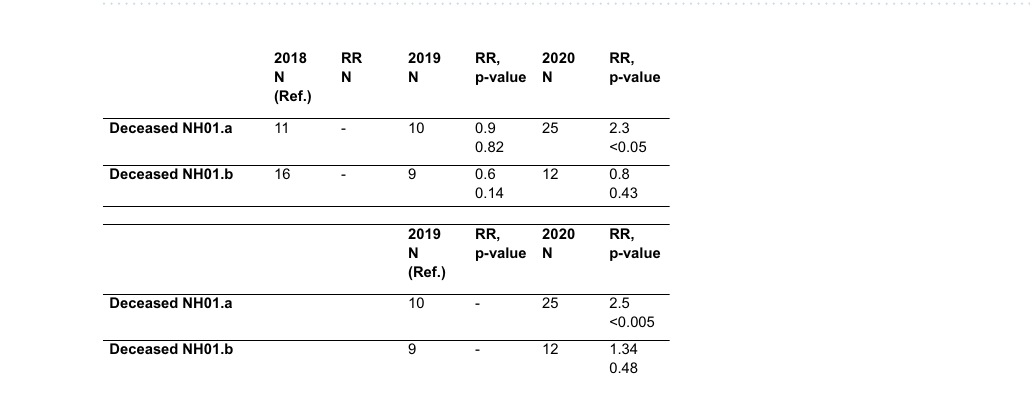
Figure 12. Excess Mortality among residents of the nursing home NH01.a and NH01.b from 01/01 to 10/5 of the years 2018–2020. Data are given in n-numbers and Risk Ratios (RR). Differences in infection numbers by year were tested for significance using a Chi-square